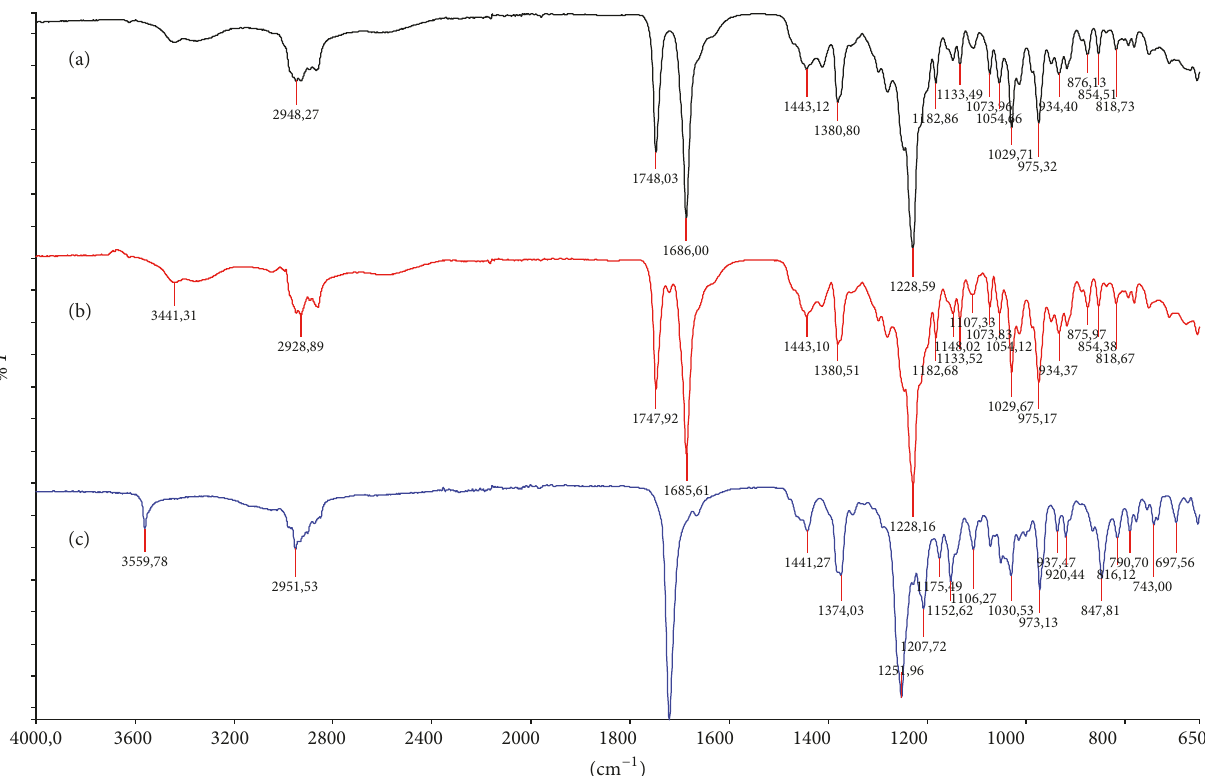
Figure 2: FTIR spectra of FA from Manufacturers A, B, and C demonstrating major differences in the region 1600cm −1 to 1800 cm −1 . Spectra (a) and (b) correspond to polymorphic Form III and show major differences as compared to spectrum (c) which shows polymorphic Form I.